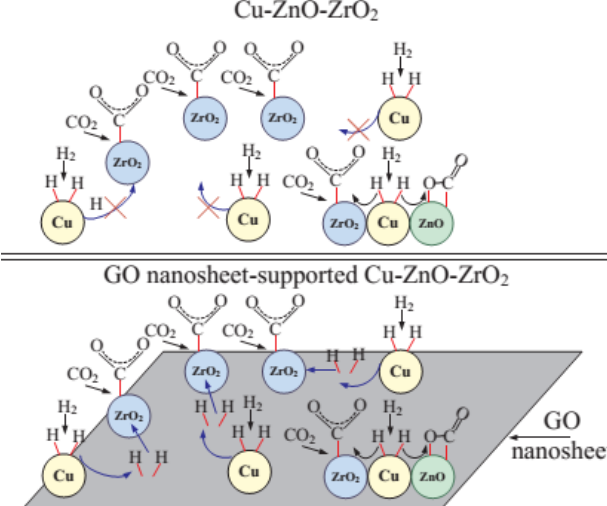
Figure 10. Graphene oxide (GO) nanosheet as a bridge promoting hydrogen spillover from the surface of copper to the surface of other metal oxides, reproduced with permission from [45]. Copyright